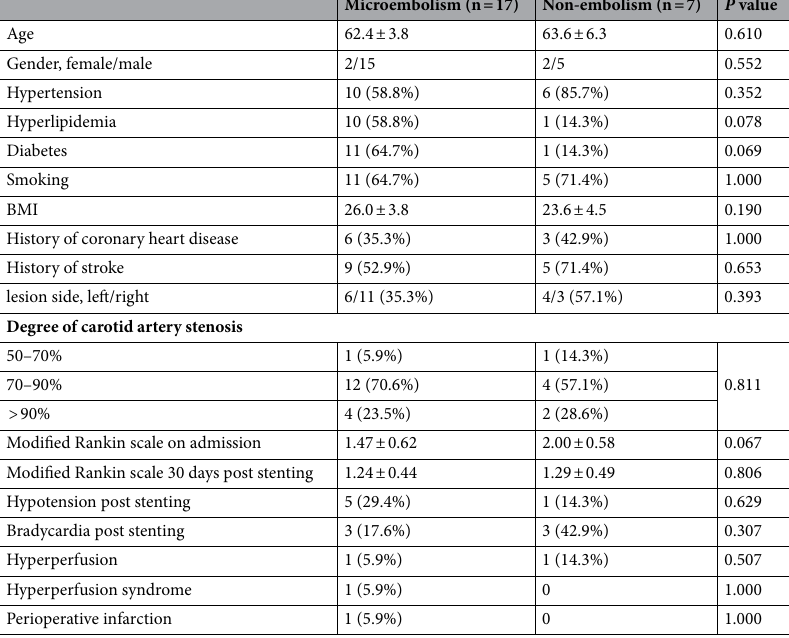
Table 1. Patient characteristics and periprocedural events in patients with or without